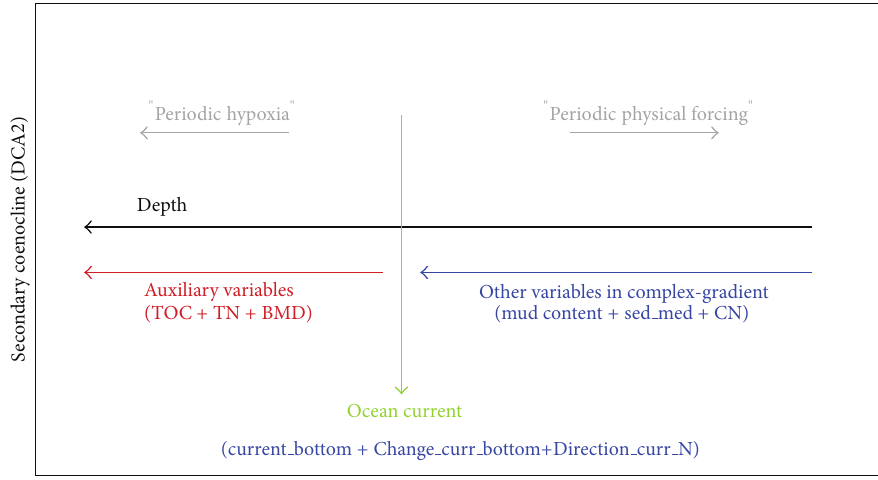
Figure 8: Conceptual model summarising major complex-gradients and auxiliary variables related to the main and secondary coenoclines. Hypothesised ecoclines related to the main coenocline are given in